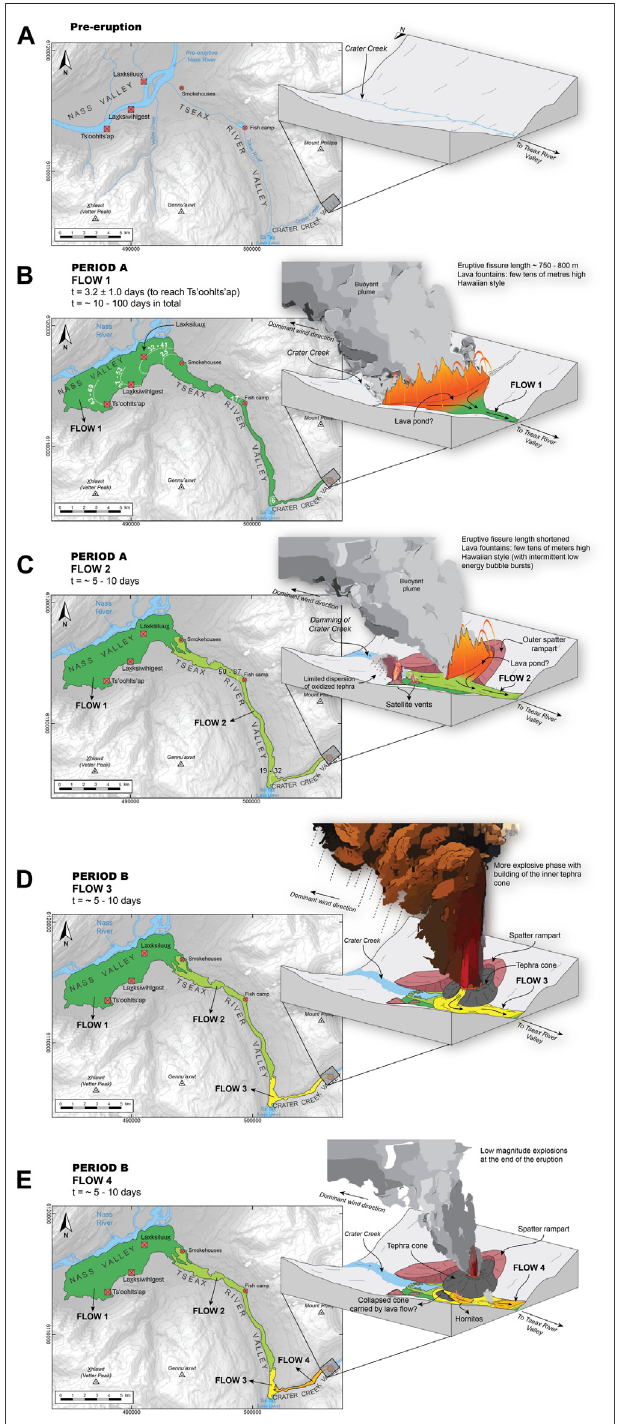
FIGURE 10 | Main eruptive events of the ~1,700 CE eruption of Tseax volcano. (A) Pre-eruption settings. (B) Period A, Flow 1: the eruption started with the opening of a 750 – 800 m long fi ssure, creating a lava curtain a few tens of meters high typical of Hawaiian eruption style. Early stages had high effusion rates and emission of a p ā heohoe lava fl ow that reached the Nass Valley and the Nisga ’ a villages in 1 – 2 days. The fl ux progressively